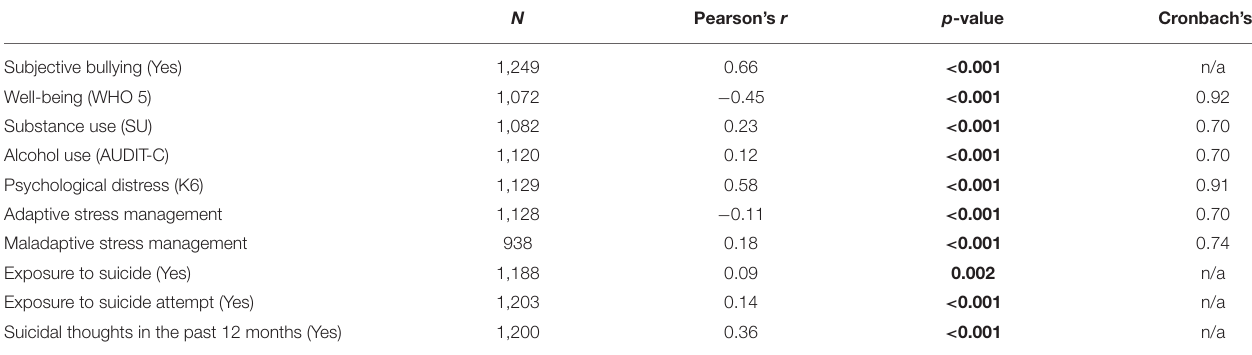
TABLE 5 | Correlations between self-reported bullying (NAQ-R, Cronbach’s α = 0.95) and other